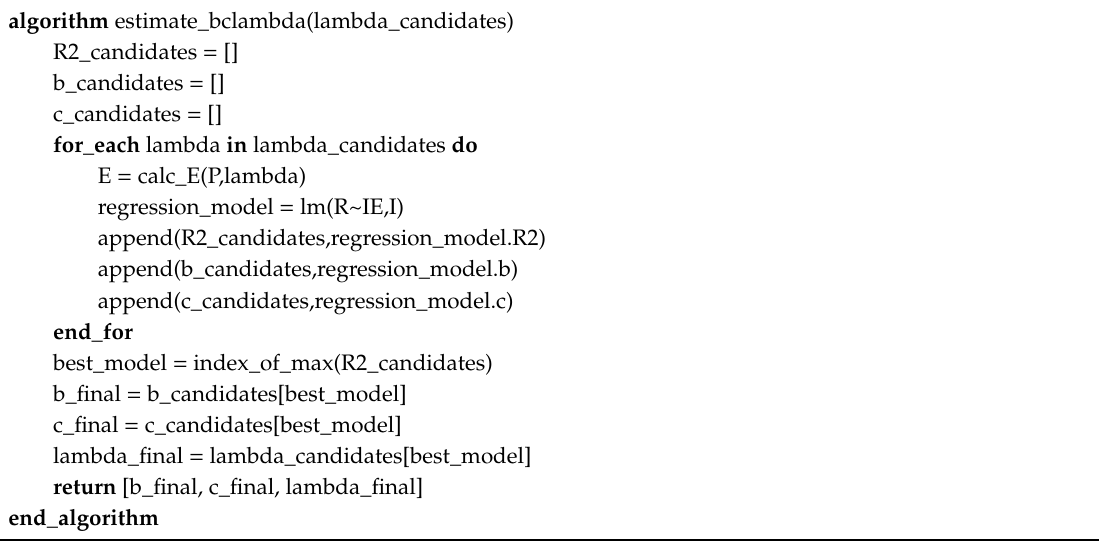
Algorithm 1. Algorithm to evaluate di ff erent bandwidths for exposure. algorithm